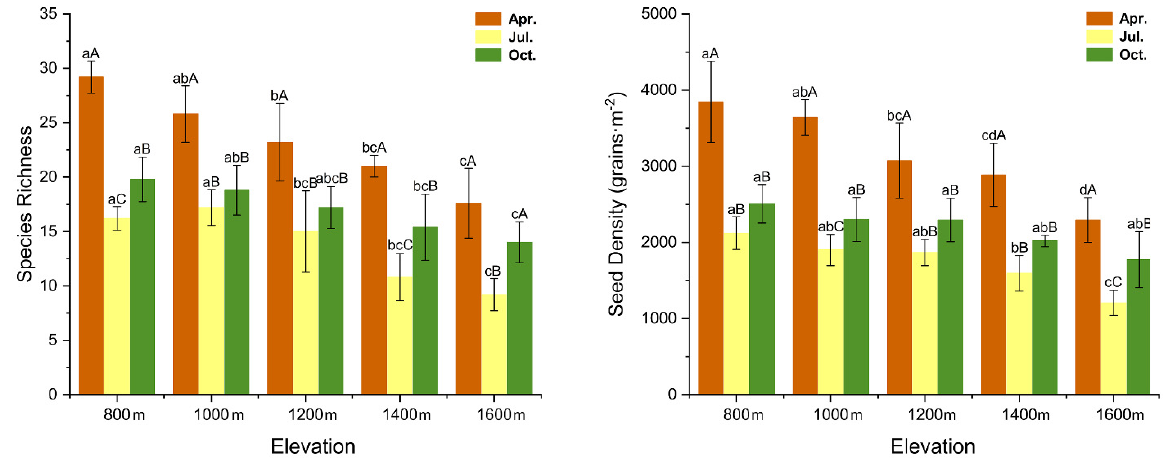
Figure 3. Species richness and seed density dynamics in the soil seed banks at different elevations and seasons. Different lowercase letters indicate significant differences ( p < 0.05) among different elevations in the same season, and different uppercase letters indicate significant differences ( p < 0.05) among different seasons at the same elevation (ANOVA and Tukey range